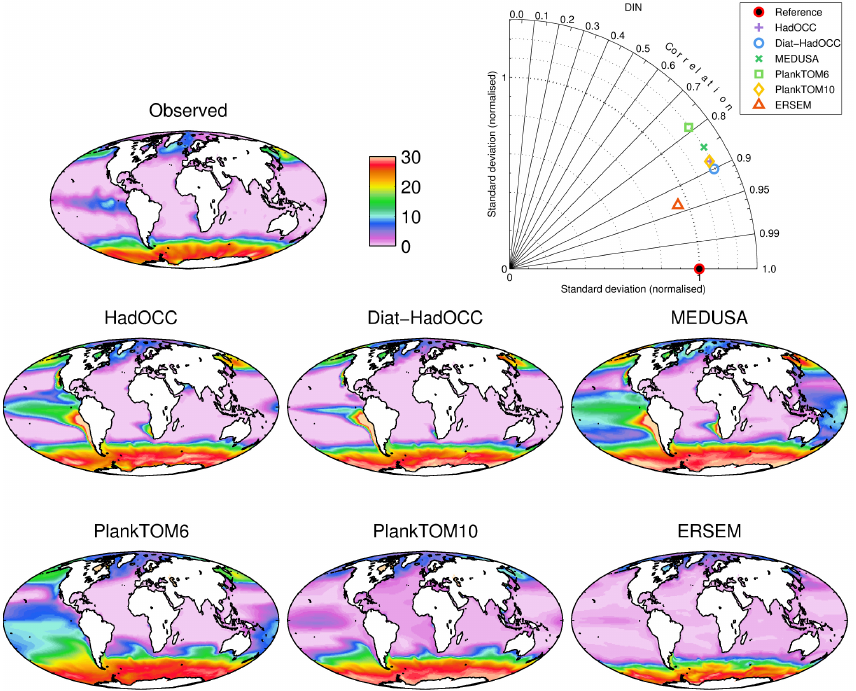
Figure 2. Observational (World Ocean Atlas, 2009; top left) and modelled annual average surface ocean dissolved inorganic nitrogen (mmolm − 3 ) for the period 2000–2004. Mean field values: observations 5.24; HadOCC 7.88; Diat-HadOCC 6.33; MEDUSA 10.18; Plank- TOM6 9.45; PlankTOM10 7.25; ERSEM